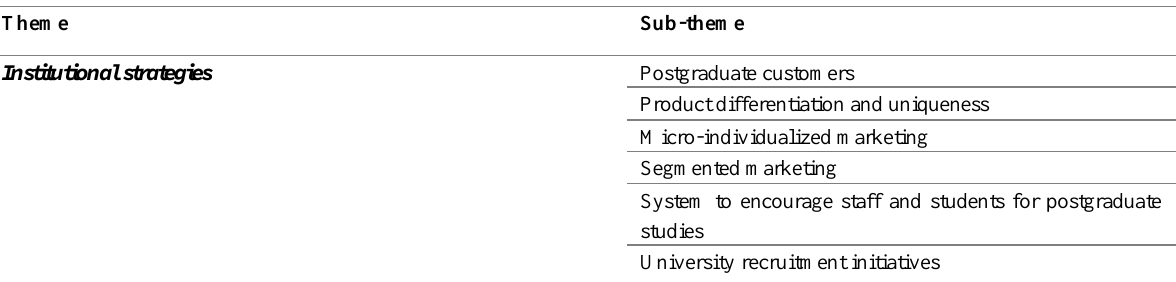
Table 1 : Identification of themes and